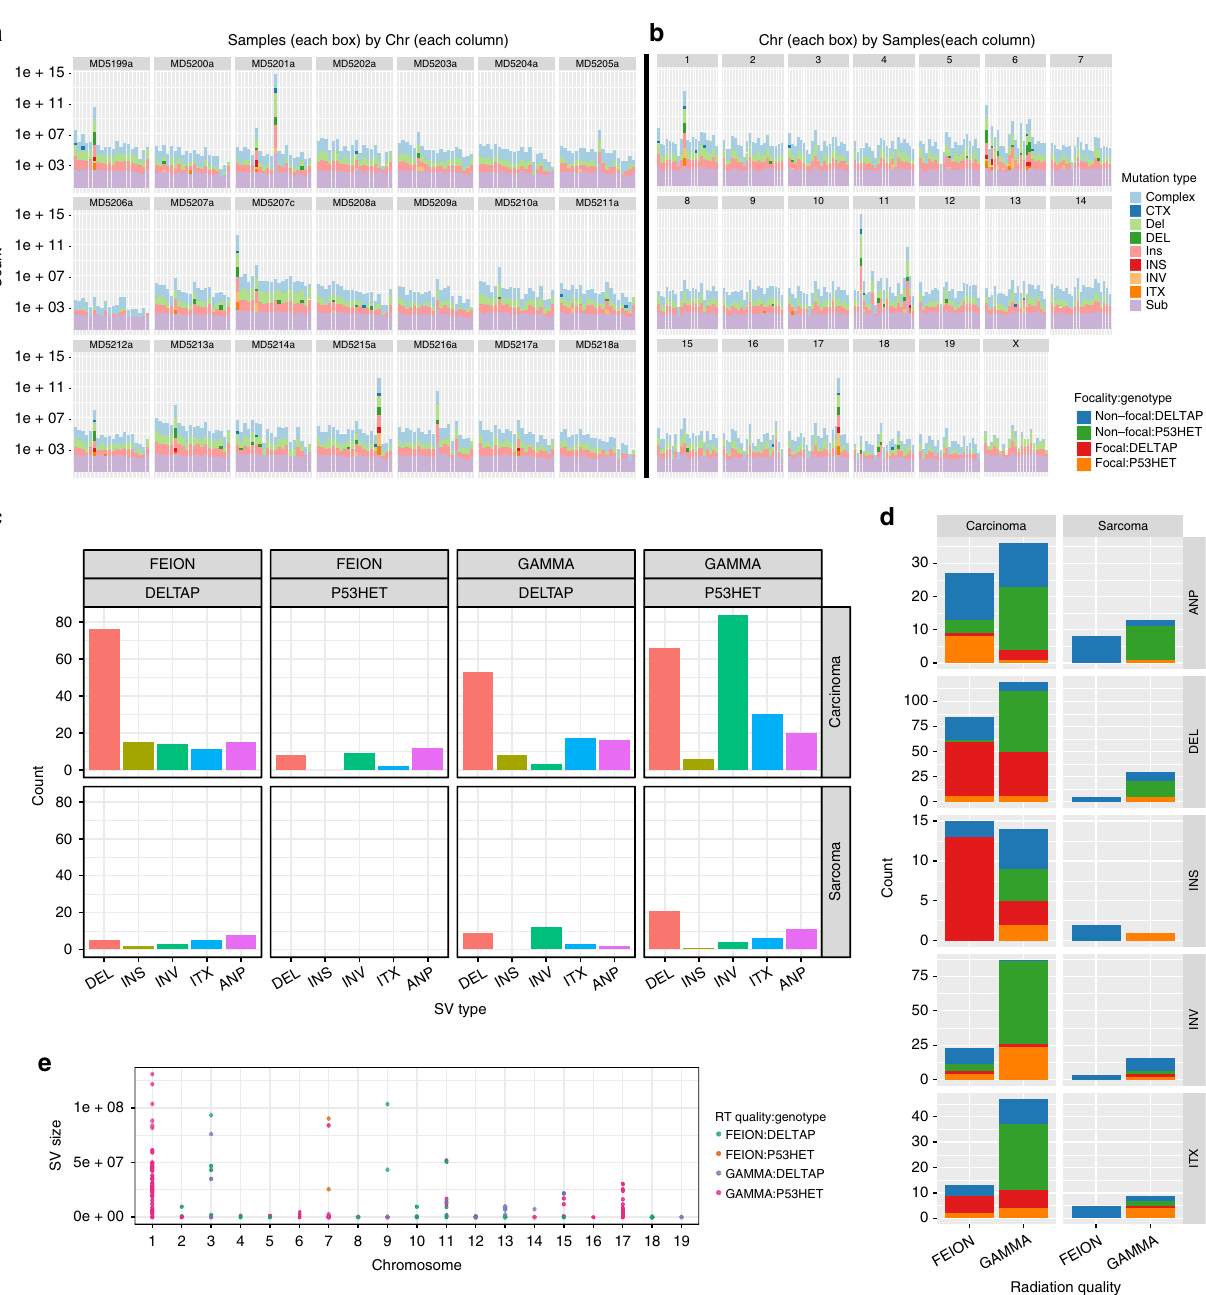
Fig. 3 The mutation landscape of SNVs and SVs across radiation-induced malignancies. a Distribution of mutations identi fi ed in mammary tumours by individual samples. Each column is one chromosome ( x -axis). Total count of mutations is on the y -axis. Mutations are coloured by type. Sub: Substitutions (SNVs), ITX: Intrachromosomal translocation, INV: Inversion rearrangements, INS: insertion rearrangements, DEL: deletion rearrangements, CTX: Complex or inter-chromosomal translocations, Complex: Complex insertions. Number of base pairs impacted by each mutation type is plotted on the y -axis in logarithmic scale. b Distribution of mutations (as in a ) in each WGS mammary tumour sample sorted by chromosome. Each column corresponds to one unique sample and each facet box encompasses one chromosome. Large scale variants were found mainly in chromosomes 1, 6, 11 and 17. c Frequency ( x -axis) of structural variants observed in mammary tumours based on radiation quality, Trp53 genotype and tumour histology. ITX: intrachromosomal translocation, INV: inversion rearrangements, INS: insertion rearrangements, DEL: deletion rearrangements, ANP: aneuploidy. Carcinomas have more SVs than sarcomas from the same cohort of mice, and large inversions are enriched in tumours from Trp53 + / − mice exposed to gamma radiation. d Incidence of focal and non-focal genomic events in mammary tumours based on radiation quality, germline Trp53 genotype and tumour histology. A higher rate of focal mutations (red and orange blocks) is observed in Fe-Ion associated carcinomas. Large non-focal structural variants (green and blue blocks) were more prevalent in samples induced by gamma radiation. Mammary sarcomas have signi fi cantly fewer structural variants than mammary carcinomas from the same cohorts of mice, independent of radiation quality and Trp53 genotype. e Distribution of structural variants identi fi ed in the same samples as in c by size across the mouse genome. Size ( y -axis) is shown by log scale. Chromosome number is shown along the bottom. Most SVs are small and less than 1 MB, as